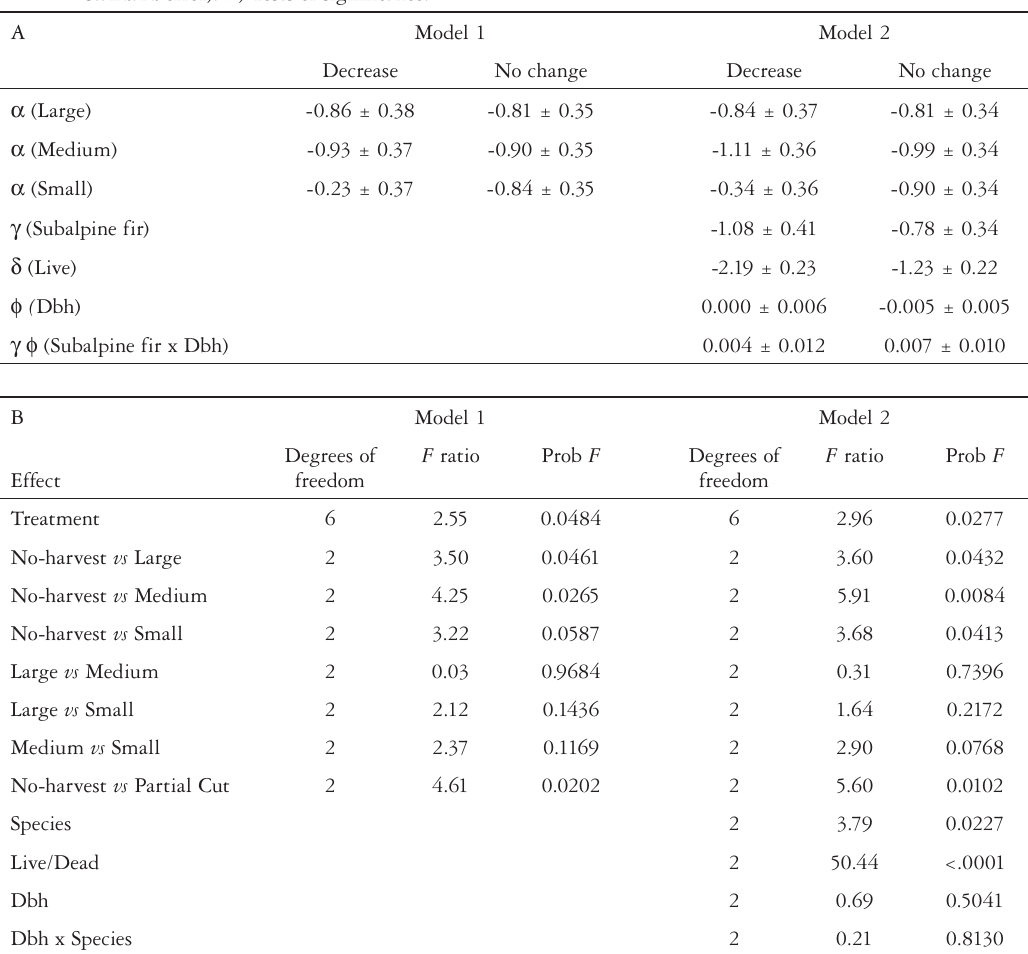
Table 4. Logistic regression models for the change in lichen abundance from 1993 to 2003, including fallen and recruited sample trees. The reference value in the analysis is the increase. A) Parameter estimates ( ± estimated standard error). B) Tests of